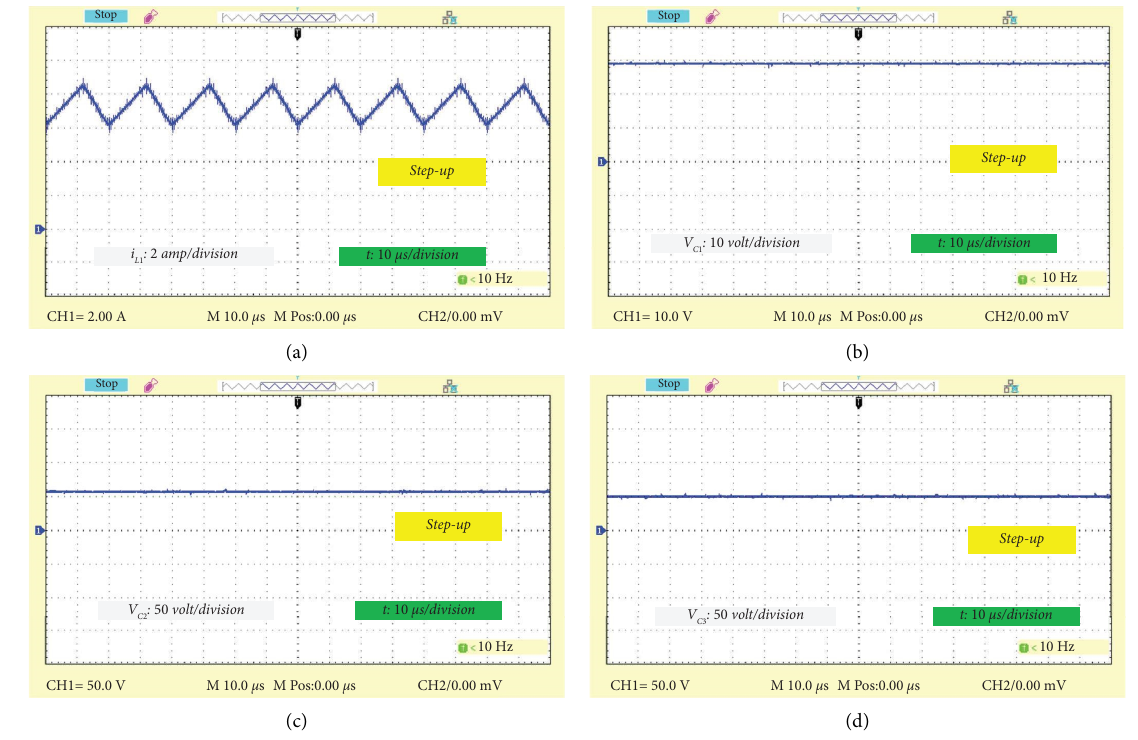
Figure 11: Waveforms in step-up mode: (a) i